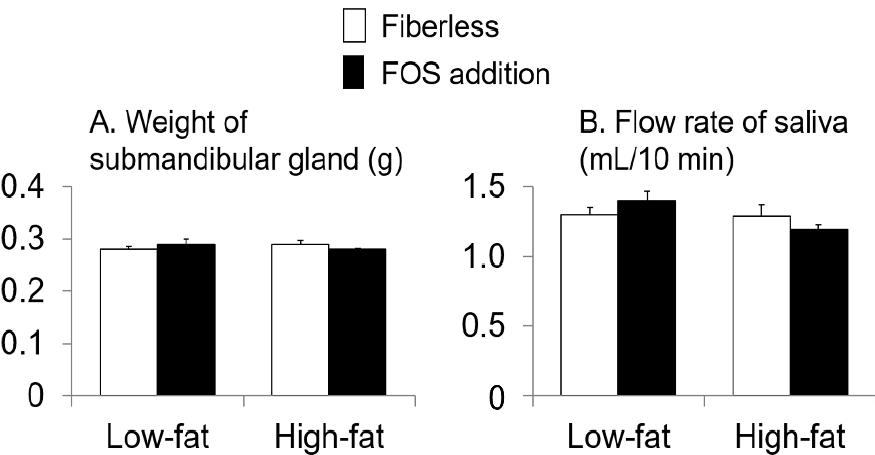
Figure 2. Effects of fat intake and fructo-oligosaccharide (FOS) supplementation on weight of submandibular gland (SMG) ( A ) and flow rate of saliva ( B ). Values are Means ± SEM. n = 8 per group. two-way analysis of variance (ANOVA).